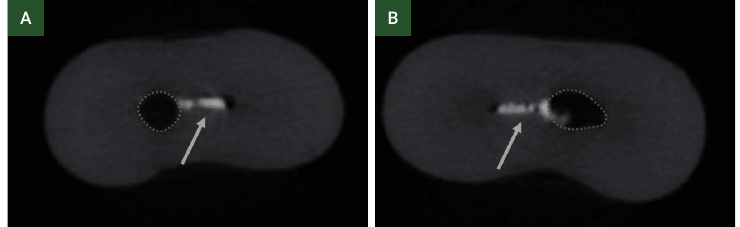
Figure 3. Post–instrumentation sections of the middle third showing: area file action (blue line), and remaining filling material (yellow arrows) in the RT (A) and MN (B)